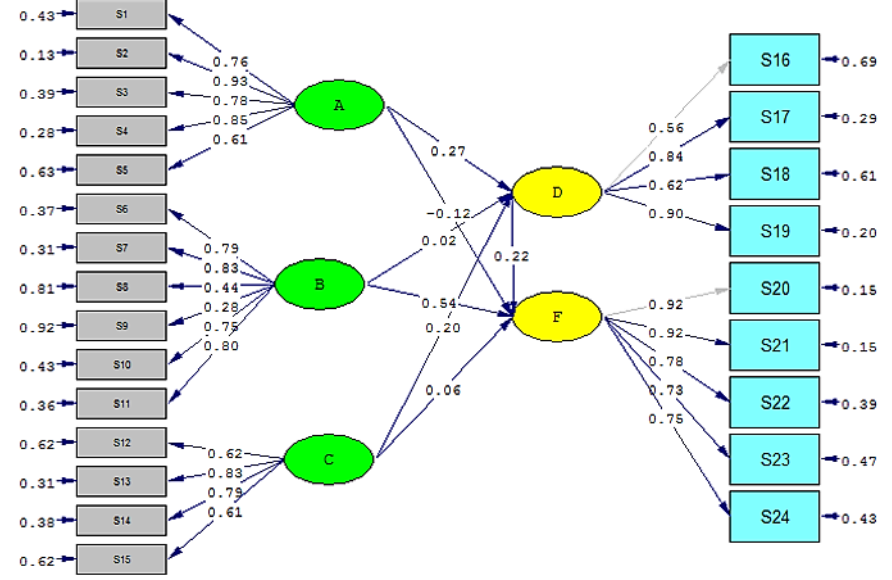
Fig. 3. Standardized coefficient model of structural model.